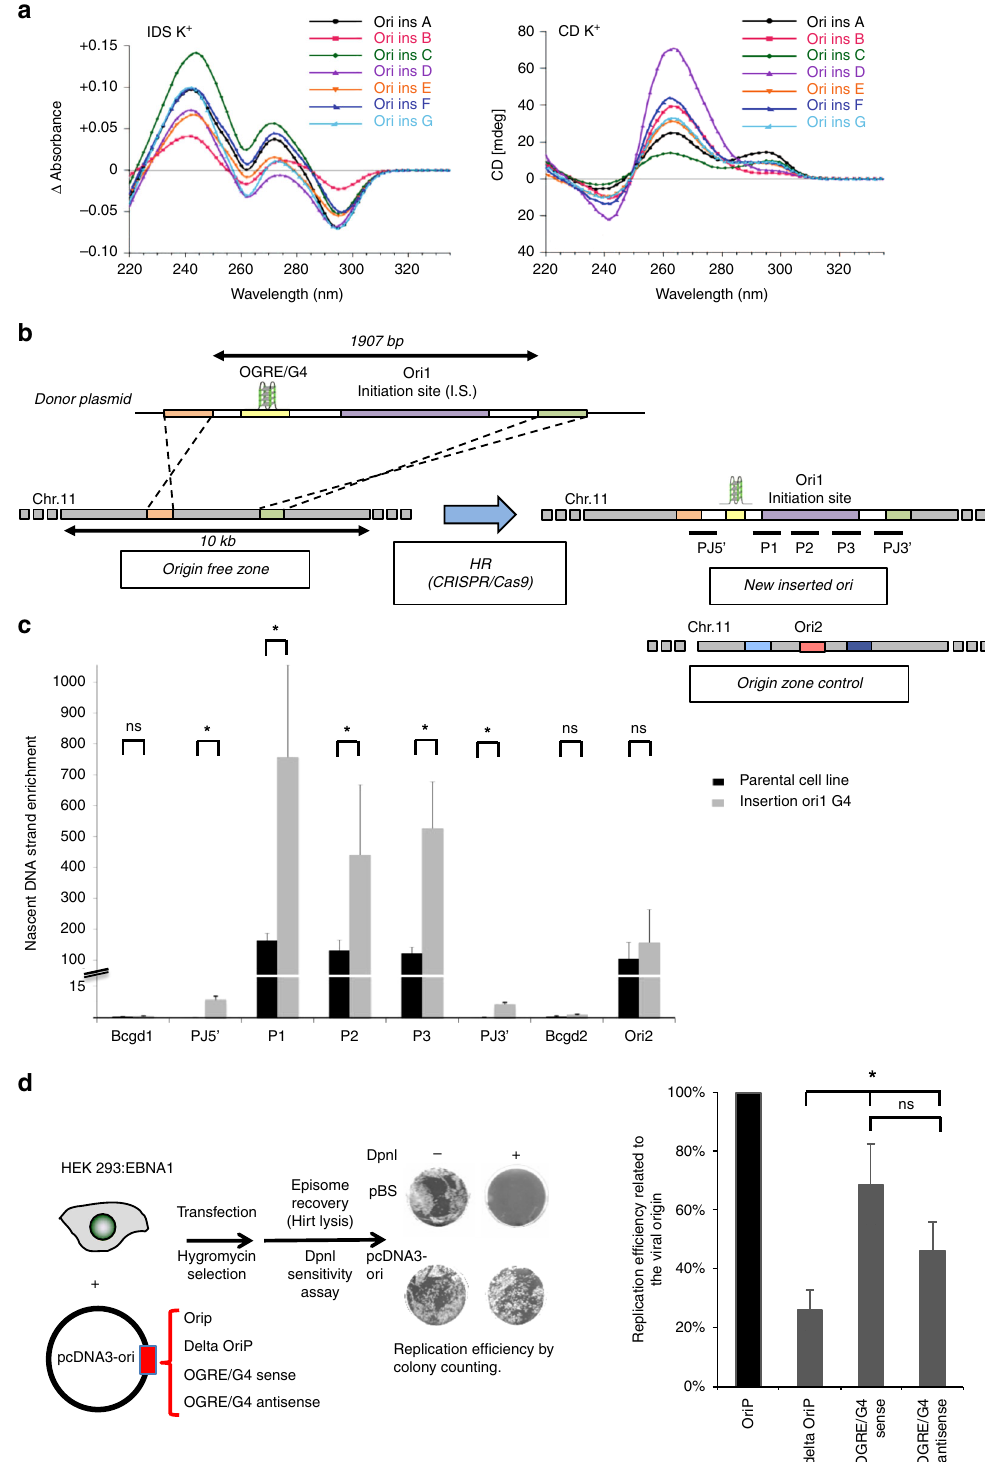
right panel). Insertion of a 500 bp mouse OGRE/G4-containing origin (Ori2; Supplementary Table 1) at the place of OriP (Fig. 1d) also promoted episomal DNA replication almost as ef fi ciently as the viral origin. As previously shown, the OGRE/G4 presence is orientated relative to the initiation site, as initiation occurs always downstream to the OGRE/G4 3,4 . So, when the antisense sequence is used, the initiation site will be in the other